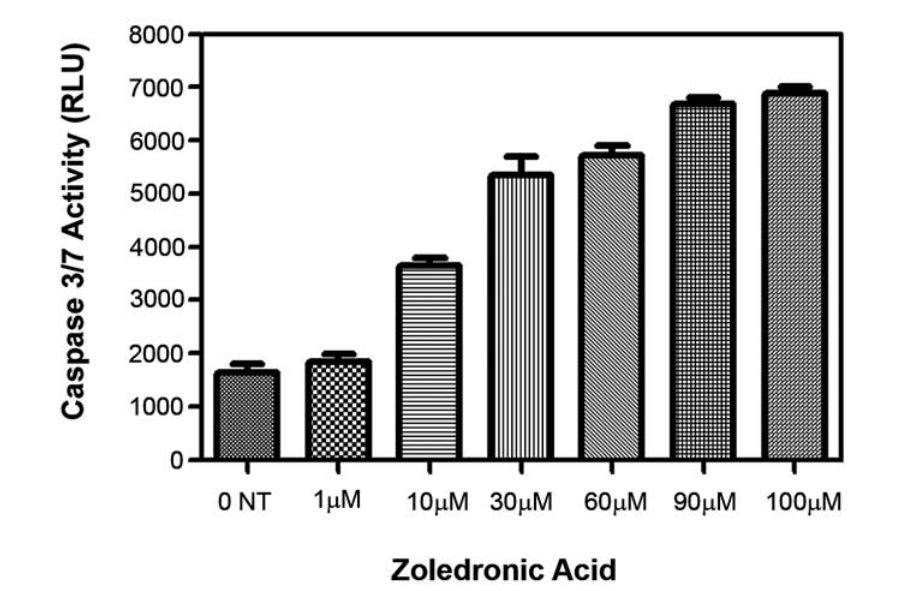
Figure 2 – Concentration dependent caspase 3/7 activity in PC-3 cell line following exposure to zoledronic acid. PC-3 cell line was treated with increasing concentrations of zoledronic acid for 72 hours and then the levels of caspase 3/7 was measured using caspase-